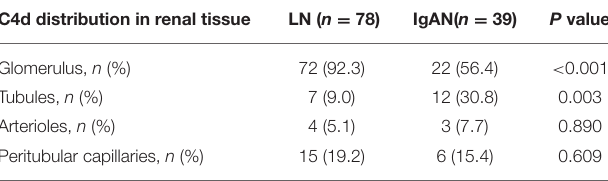
TABLE 1 | Clinical and histologic characteristics at baseline for LN, IgAN and healthy control patients. Characteristics